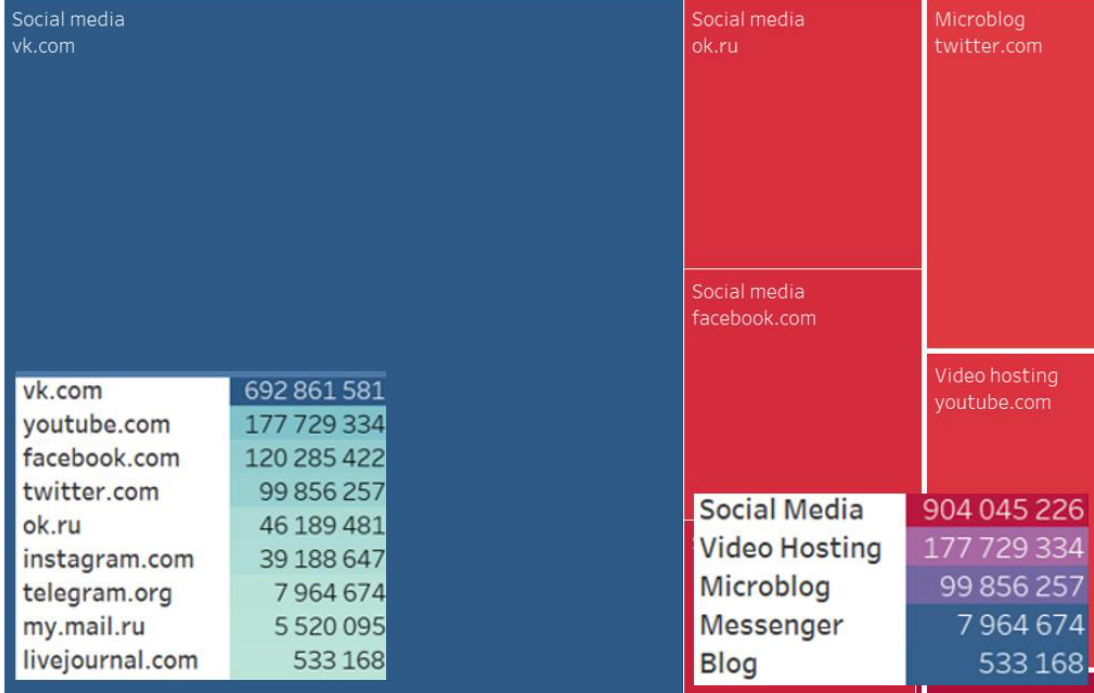
Figure 2. Digital platforms and social media types.